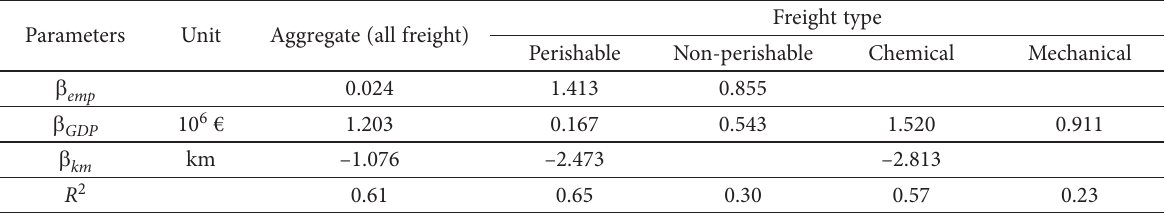
Table 7. Distribution model for import: calibration results